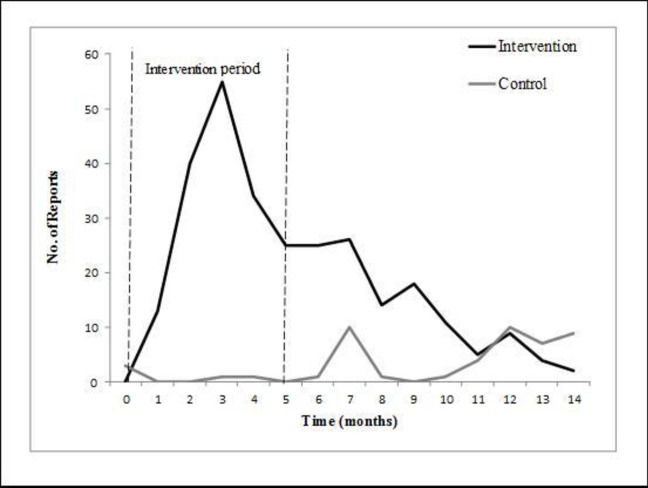
Number of ADR reports in the intervention vs. the control groups during the study period.A rapid and substantial increase in the number of ADR reports was noted in the intervention group during the 5-month intervention period, which gradually decreased toward the end of the study.